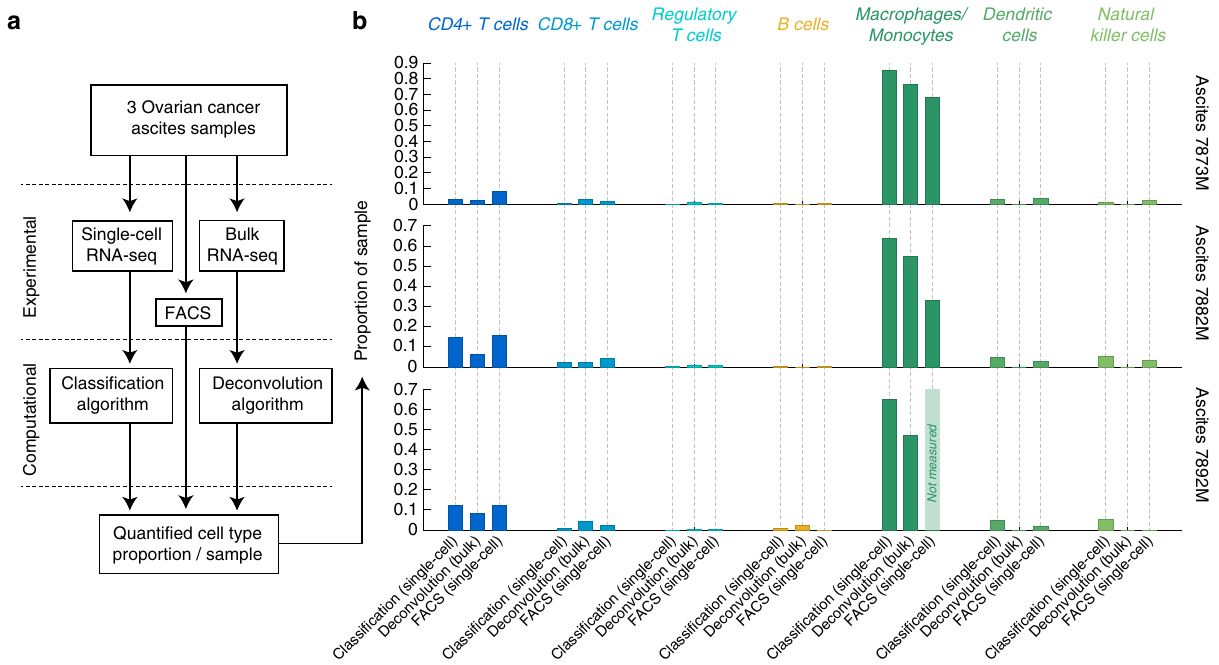
Fig. 6 Estimates of cellular composition by three different methods. Three ovarian cancer ascites samples were pro fi led by single-cell and bulk RNA sequencing, as well as FACS. a Process diagram of data and results generation for three ovarian cancer ascites samples. b Estimates of the cellular composition are derived by: (1) classi fi cation based on single-cell RNA sequencing data; (2) computational deconvolution on the bulk RNA sequencing data using the single-cell RNA sequencing derived RGEP3; (3) quanti fi cation by FACS. For sample 7892, macrophages/monocytes quanti fi cation could not be determined by